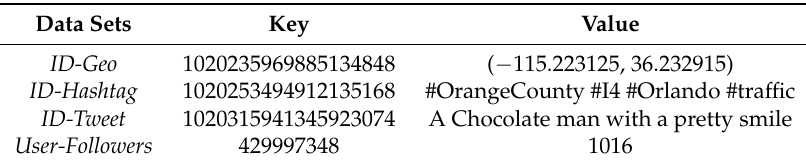
Table 5. The samples of real data